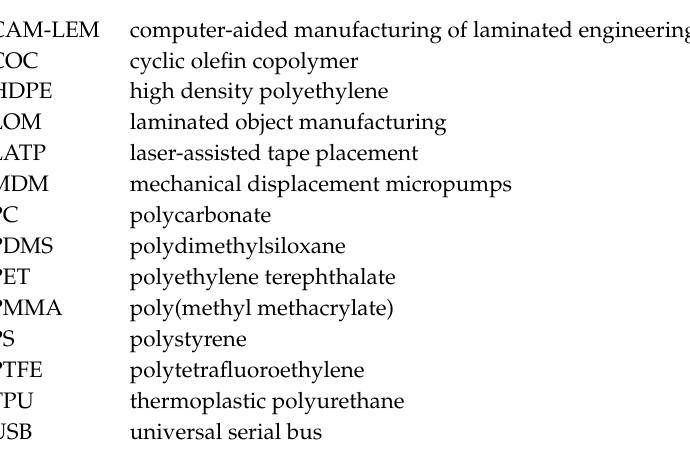
Figure S1: Droplets in a zig-zag structure, Figure S2: Dry channels and droplets moving within an oil-sheath. Author